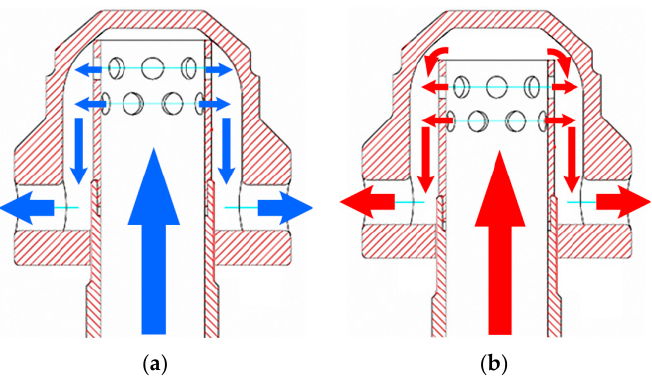
Figure 7. Effect of contact between the cover and inner tube on air flow. ( a ) the air flow under designed state; ( b ) the air flow with the presence of a top gap.